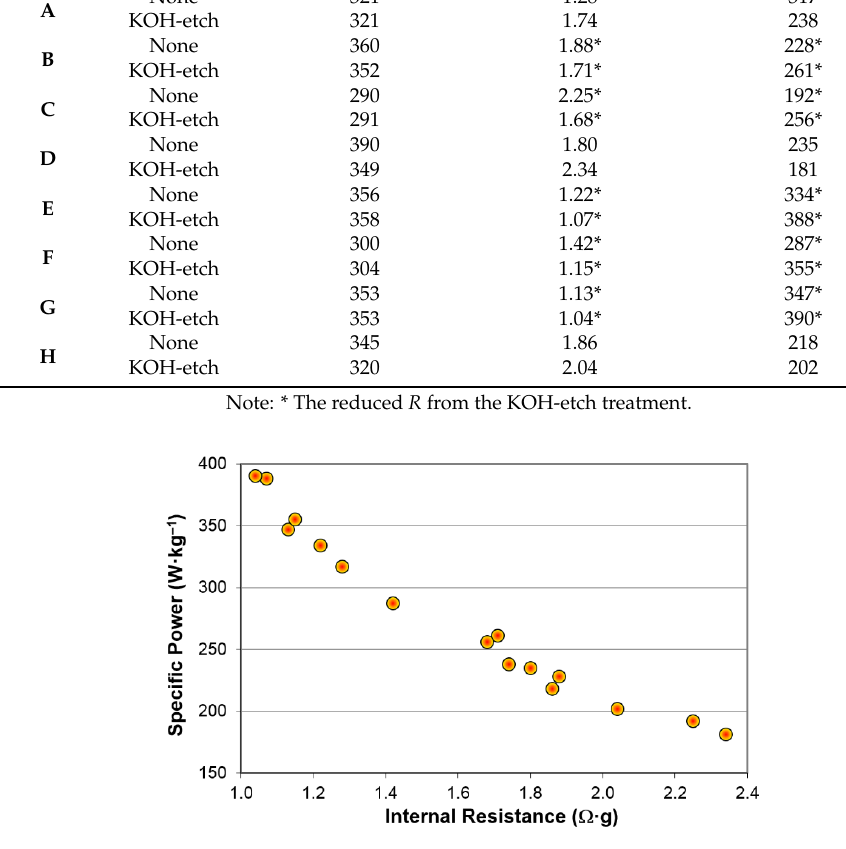
Figure 5. Plot of the calculated specific power vs. internal resistance for as-is and etched A – H . The superiority of E vs. A in the high-rate performance has been verified by room-temperature AC impedance measured at different frequencies as shown in Figure 6. The radius of the semi-circle represents the surface charge-transfer resistance and shows the trend of as-is A > as-is E > etched E , which is in total agreement with the internal resistance measurement.